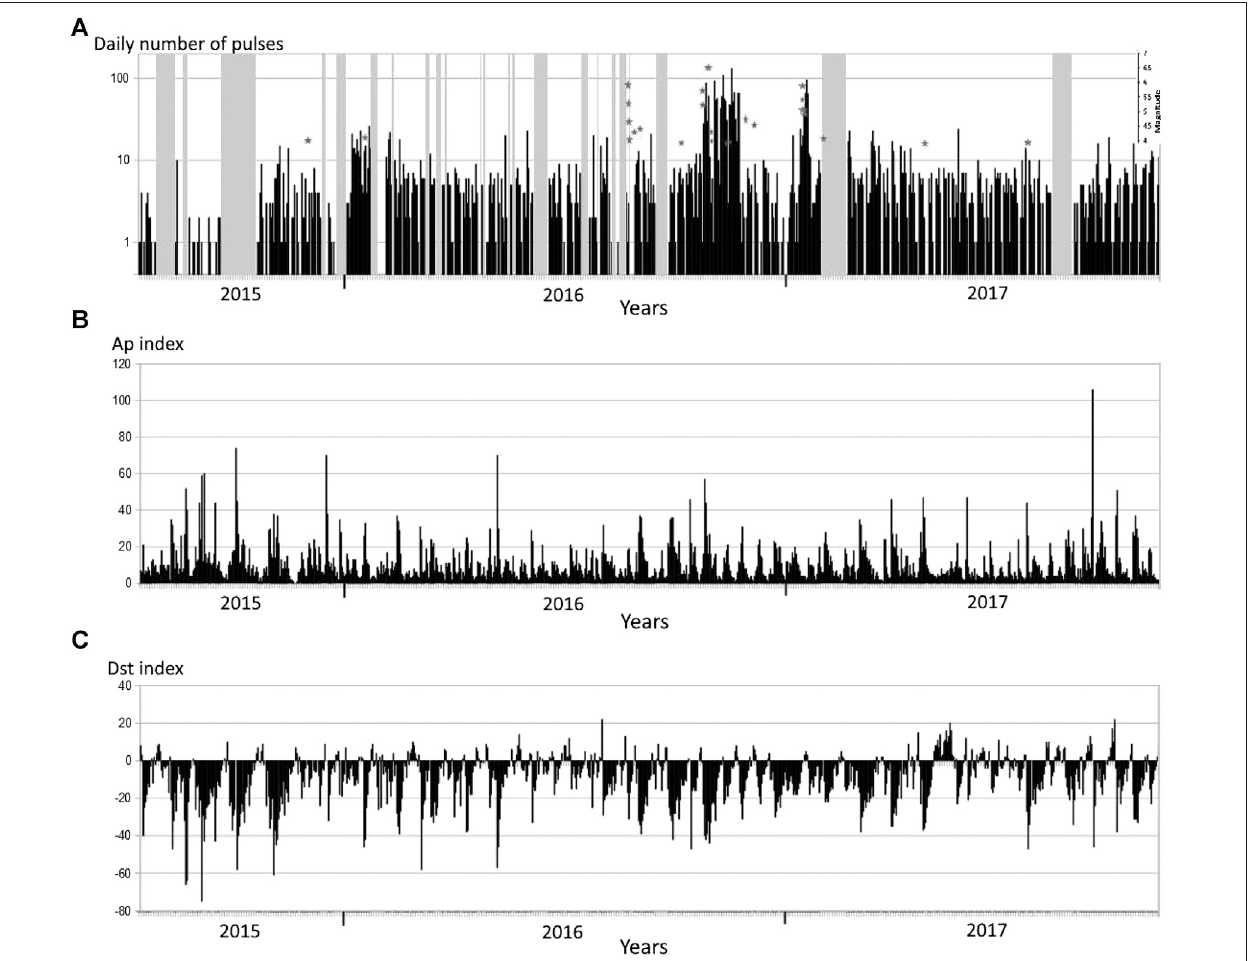
FIGURE9| ThedailynumberofmagneticpulsesrecordedbyIC1forthetime intervalfromtheendofJuly2015toOctober2017isindicatedbyverticallinesin (A) . Vertical lines in (B,C) describe geomagnetic activity by means of Ap and Dst indexes, respectively. The occurrence of strong seismic events (M ≥ 4) is indicated by grey stars. Periods of lost data are indicated by gray